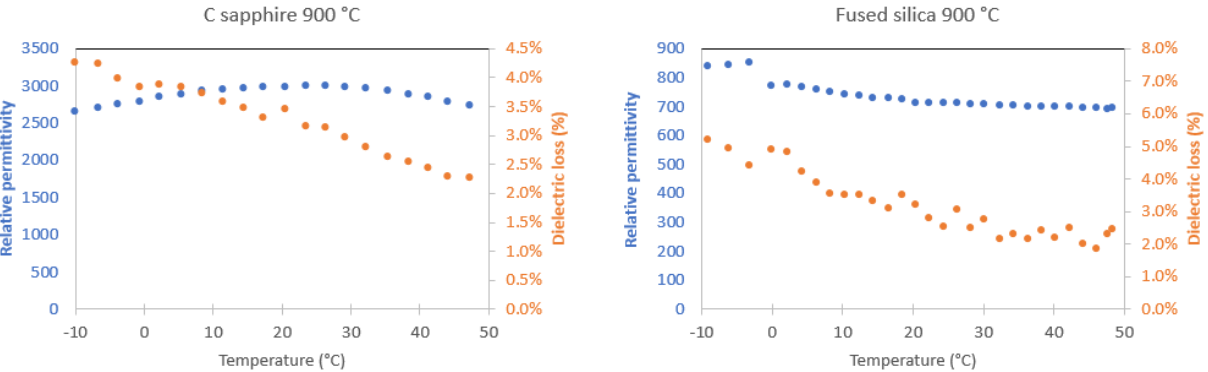
Figure 3. Permittivity versus temperature for PST on c-sapphire and FS substrates annealed at 900 °C. The measurements were performed on heating.